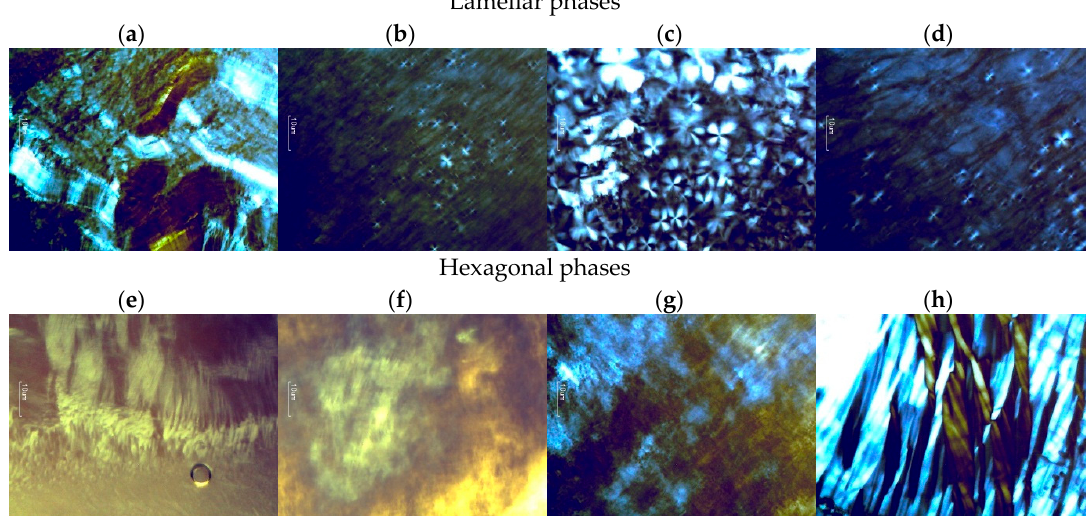
Figure 3. Photomicrographs obtained using polarized light microscopy (PLM) that shows the streaks of the hexagonal phases (IM1, IM2, P1, and P2) and Maltese crosses of the lamellar phases (OA1, OA2, OAP1, and OAP2). The sample compositions are described in Table 1; ( a ) OA1; ( b ) OA2; ( c ) OAP1; ( d ) OAP2; ( e ) IM1; ( f ) IM2; ( g ) P1; ( h ) P2.